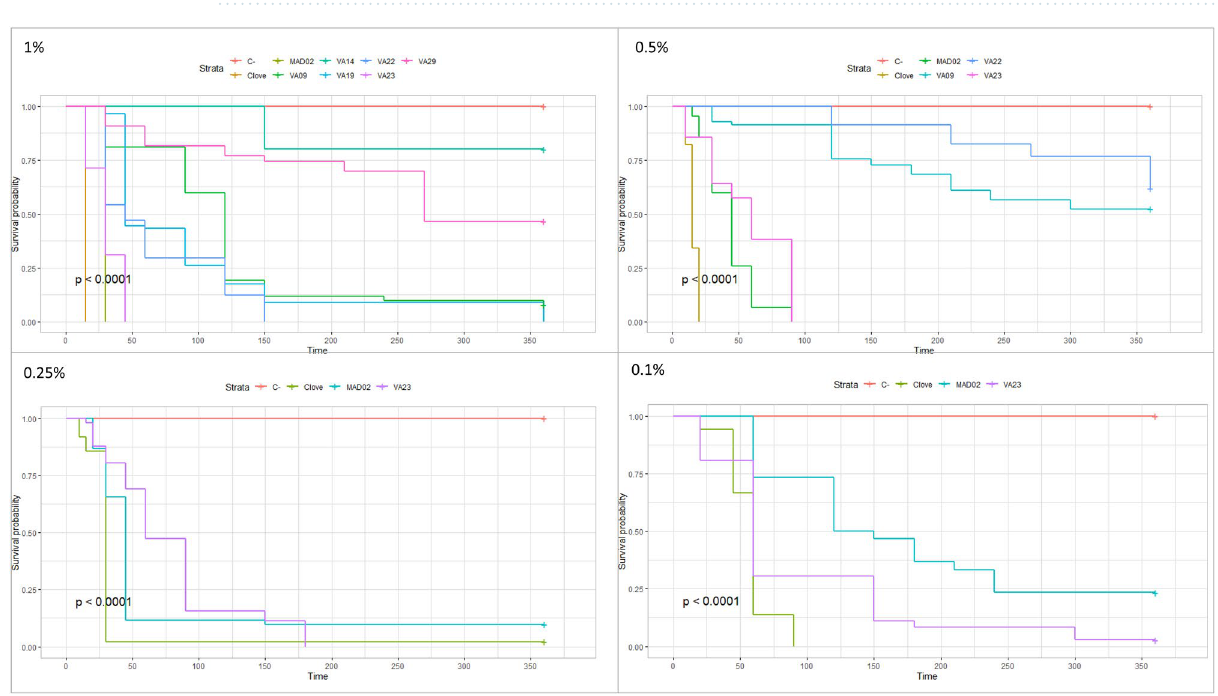
Figure 2. Survival curves of sarcoptes exposed to essential oils at 0.1%, 0.25%, 0.5%, and 1% concentrations in contact assay (C : paraffin